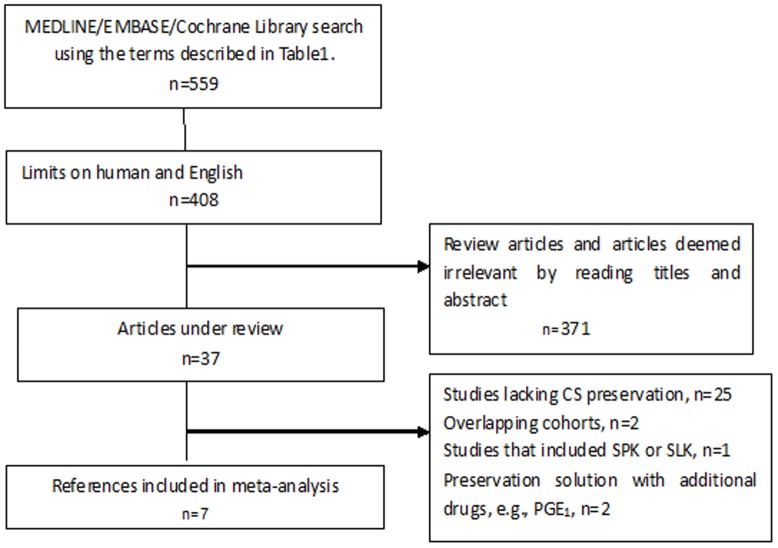
Flow chart illustrating papers selected for analysis.